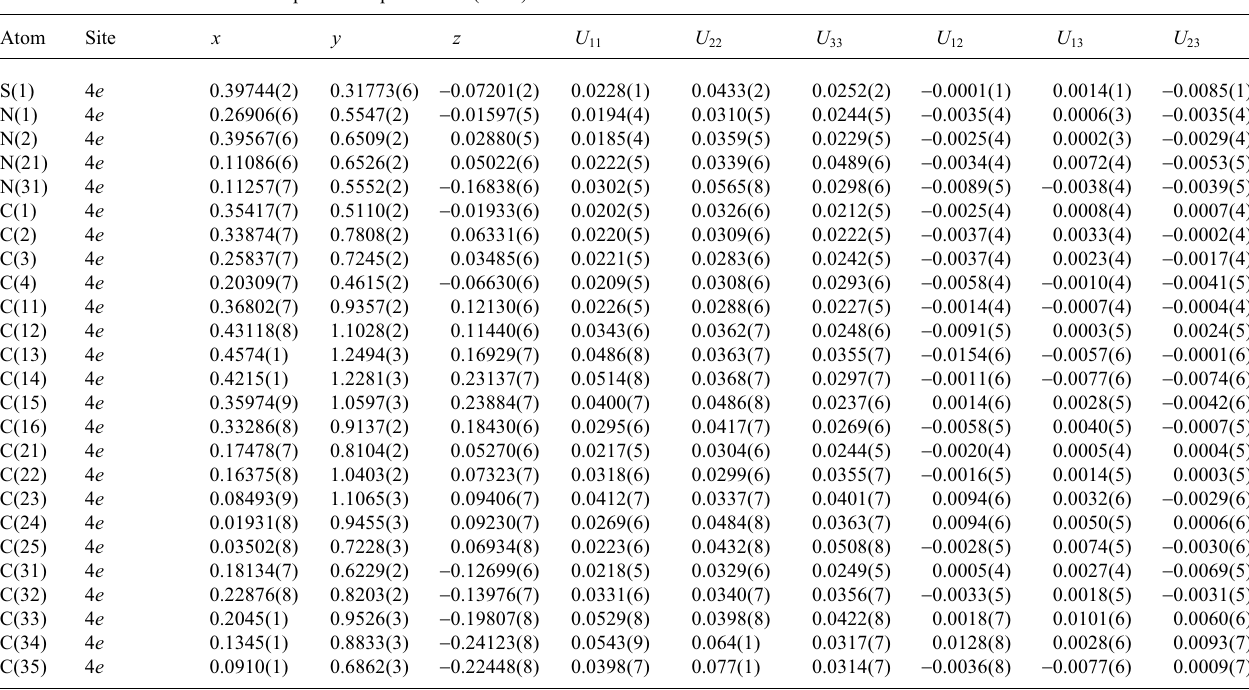
Table 3. Atomic coordinates and displacement parameters (in Å 2 )